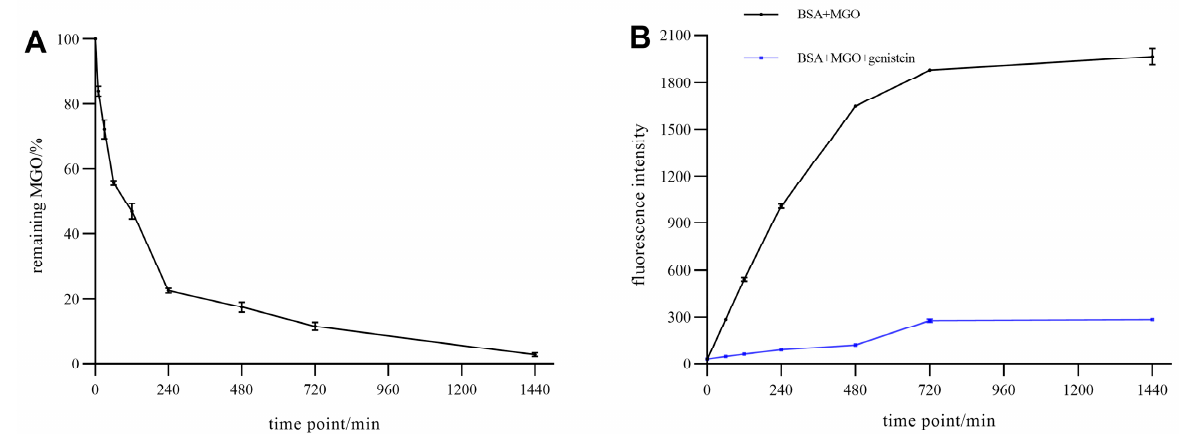
Figure 8. ( A ) Trapping of MGO by genistein under physiological environment (PH 7.4, 37 °C) and ( B ) inhibitory effect of the formation of AGEs by genistein in the BSA-MGO system.